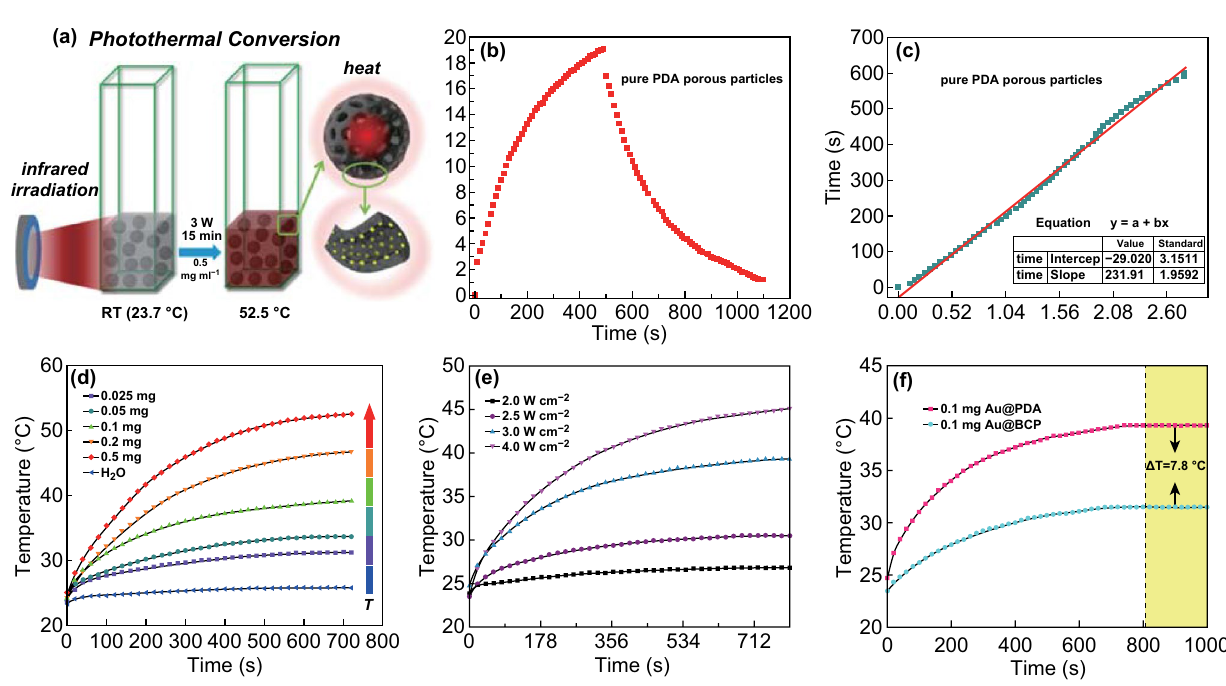
Fig. 7 a Schematic diagram of photothermal conversion of the Au@PDA particles. b The photothermal response of the PDA porous particles in aqueous solution (0.2 mg mL −1 ) for 500 s with a NIR laser (808 nm, 2 W cm −2 ), and then, the laser was shut off. c Linear time data versus − ln θ obtained from the cooling period of b . d Temperature changes of pure water and various concentrations of Au@PDA particles dispersions under irradiation with NIR light (808 nm, 3 W cm −2 ). e Temperature dependence on the irradiation power with constant particle concentration (0.1 mg mL −1 ). f Comparison of the photothermal effects of Au@PDA and Au@P2VP particles with 0.1 mg mL −1 at 3 W cm